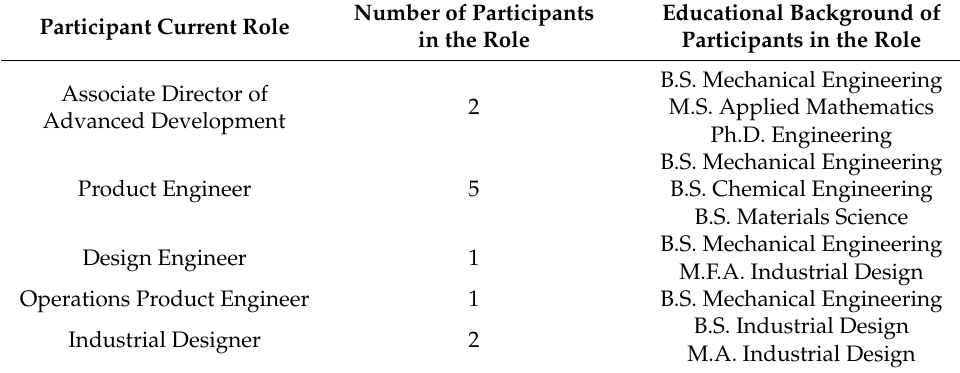
Table 2. Participant roles and credentials